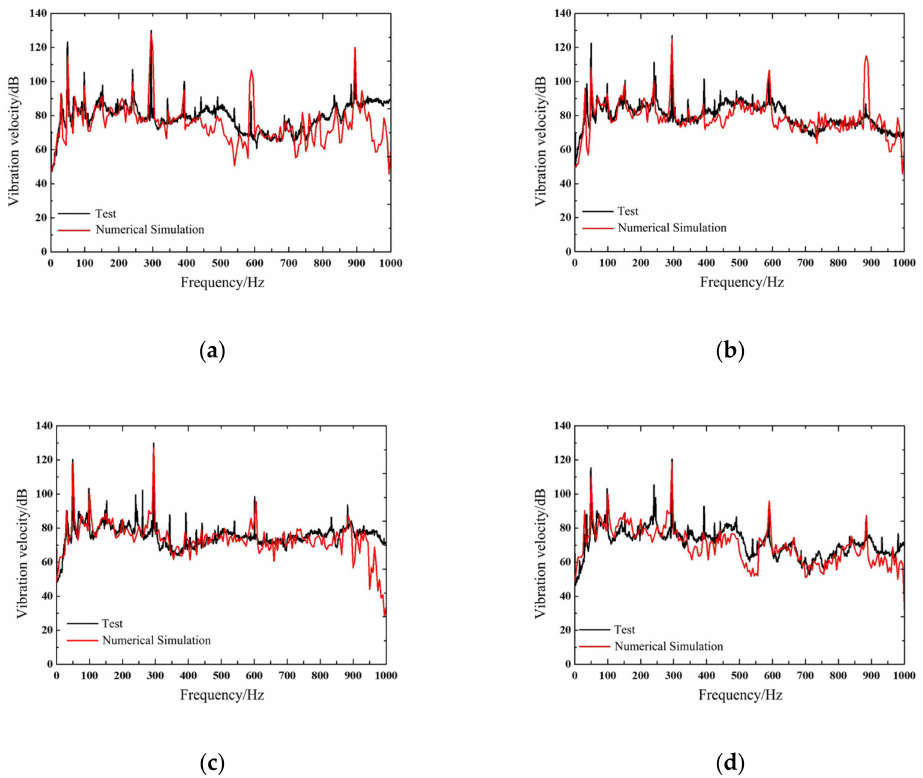
Figure 20. Comparison of the vibration generated by the fluid on the inner surface of the pump and the vibration obtained in the test: ( a ) export flange; ( b ) import flange; ( c ) connecting plate; ( d )